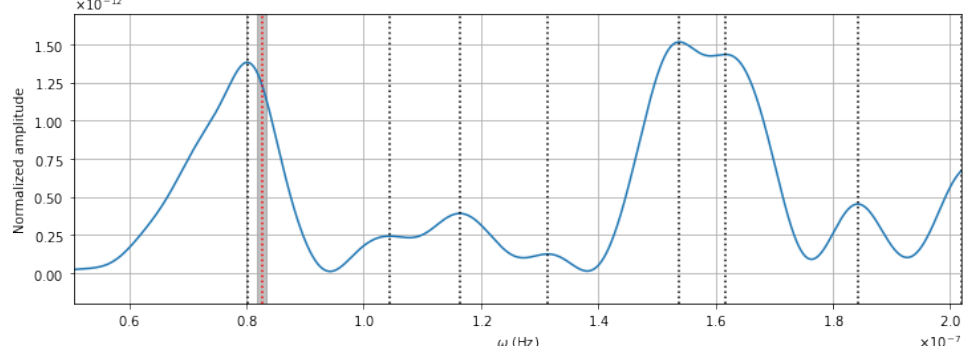
Figure 9. Plot of the LS periodogram of the wideband post-fit whitened TRs of the MSP J2145–0750. The black-dotted lines indicate the angular frequencies found by the LS algorithm. The red-dotted × 10 − 8 expected for the GWs possibly emitted line indicates the angular frequency ω = 8.262 + 0.025 − 0.025 by the SMBHB candidate PKS 2131–021. The gray shaded area indicates uncertainty on ω at the 3 σ confidence level. The horizontal axis indicates the GW angular frequency, expressed in Hertz. The vertical axis indicates the normalized amplitude,